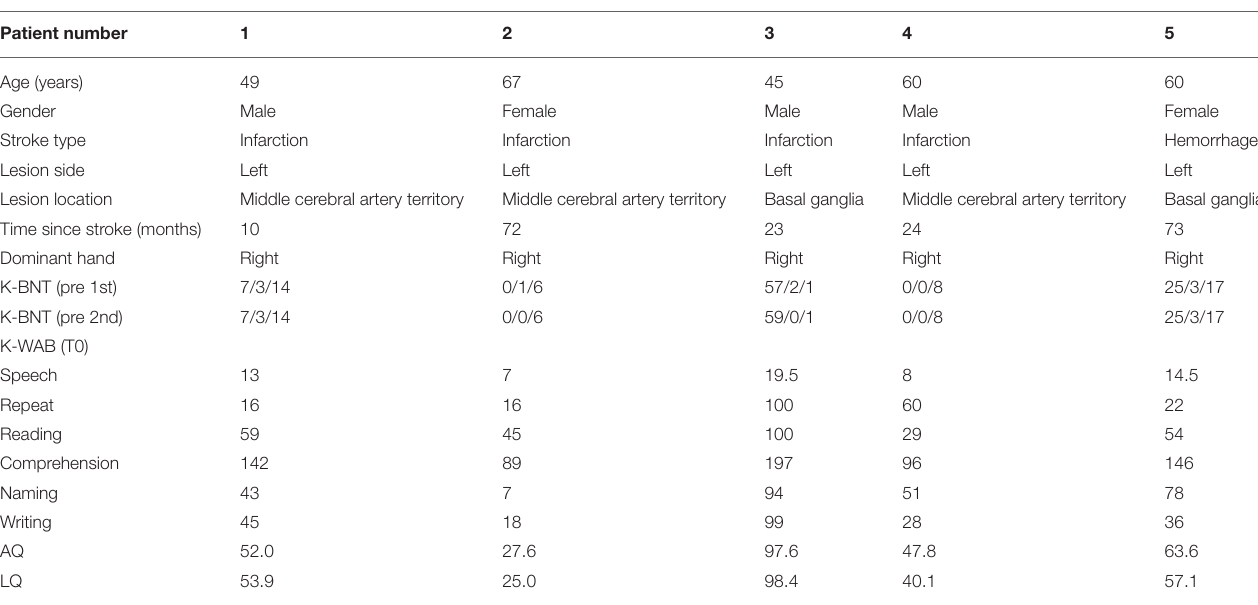
TABLE 1 | Clinical and demographic